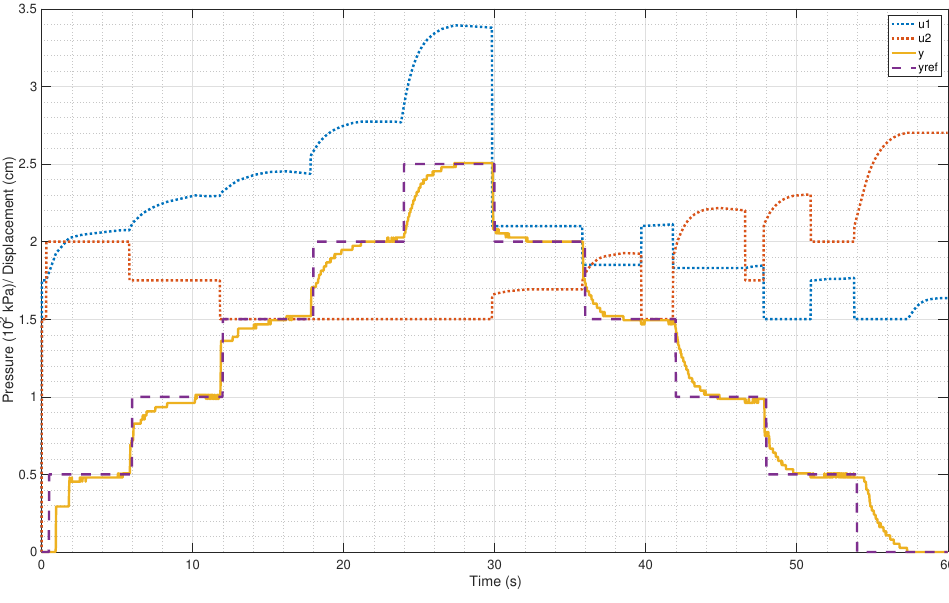
Figure 12. Graph of SMPC staircase tracking. Table 5. SMPC staircase tracking